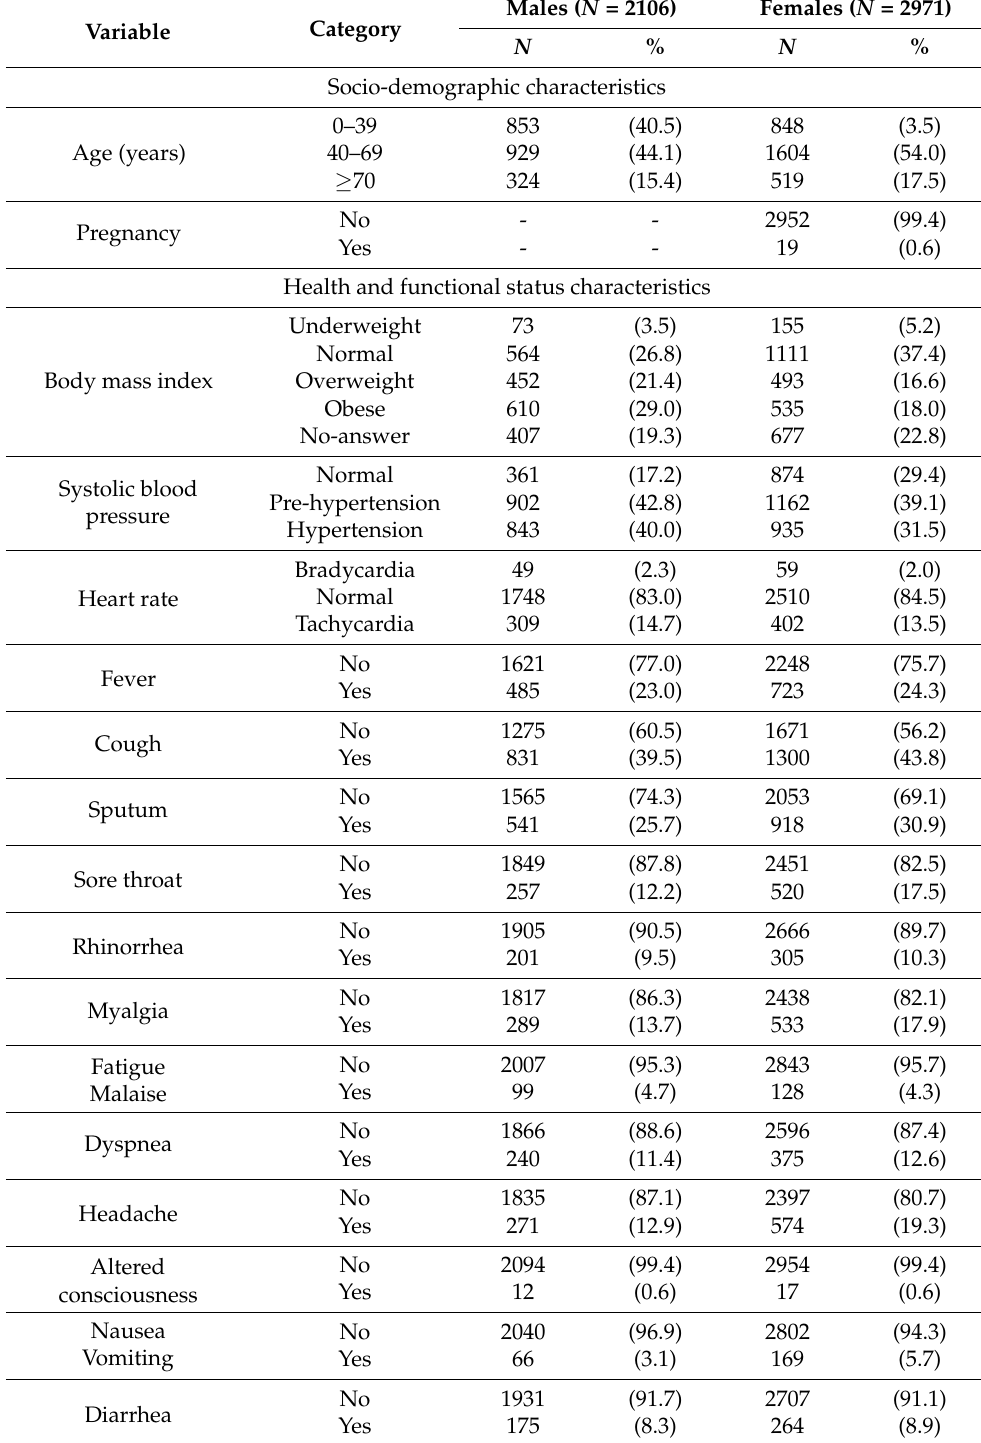
Table 1. General characteristics of the study sample by